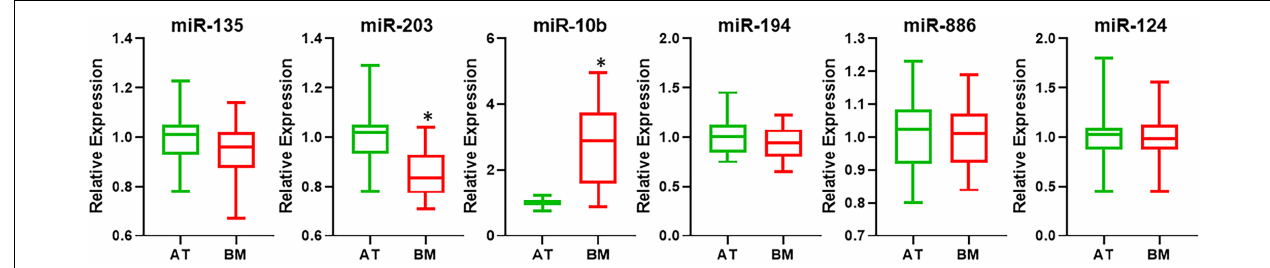
Frontiers in Cell and Developmental Biology |